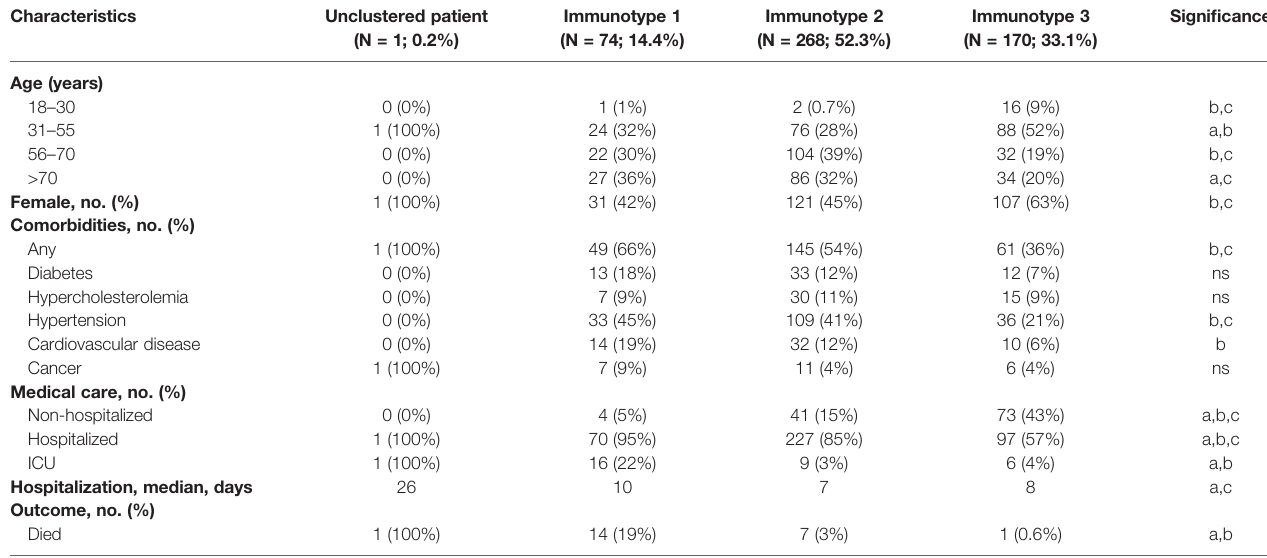
TABLE 2 | Demographics and clinical characteristics of COVID-19 patients (n=513) clustered according to their immune cell composition during SARS-CoV-2 infection.